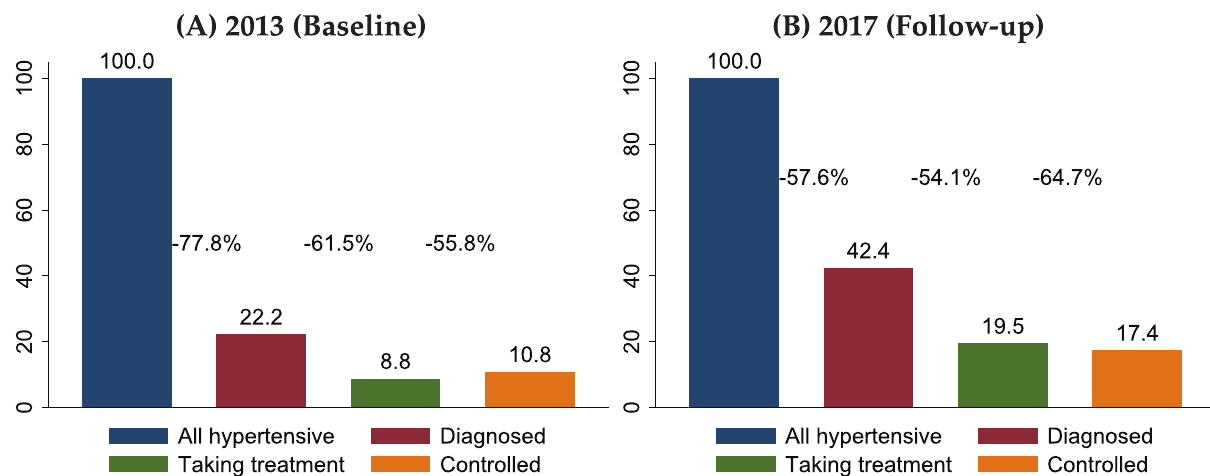
Fig 4. Cascade of care for hypertension in rural Malawi, cohort respondents age 45+ yrs. 2013–17. Notes : The cascade represents the proportion of individuals who reach each separate stage of care, conditional on being included in the previous stage. Analyses are based on respondents who participated in both the 2013 and 2017 MLSFH-MAC to ensure that variations in the study populations do not affect the findings; however, similar patterns are identified based on analyses of all 2013 or 2017 respondents.